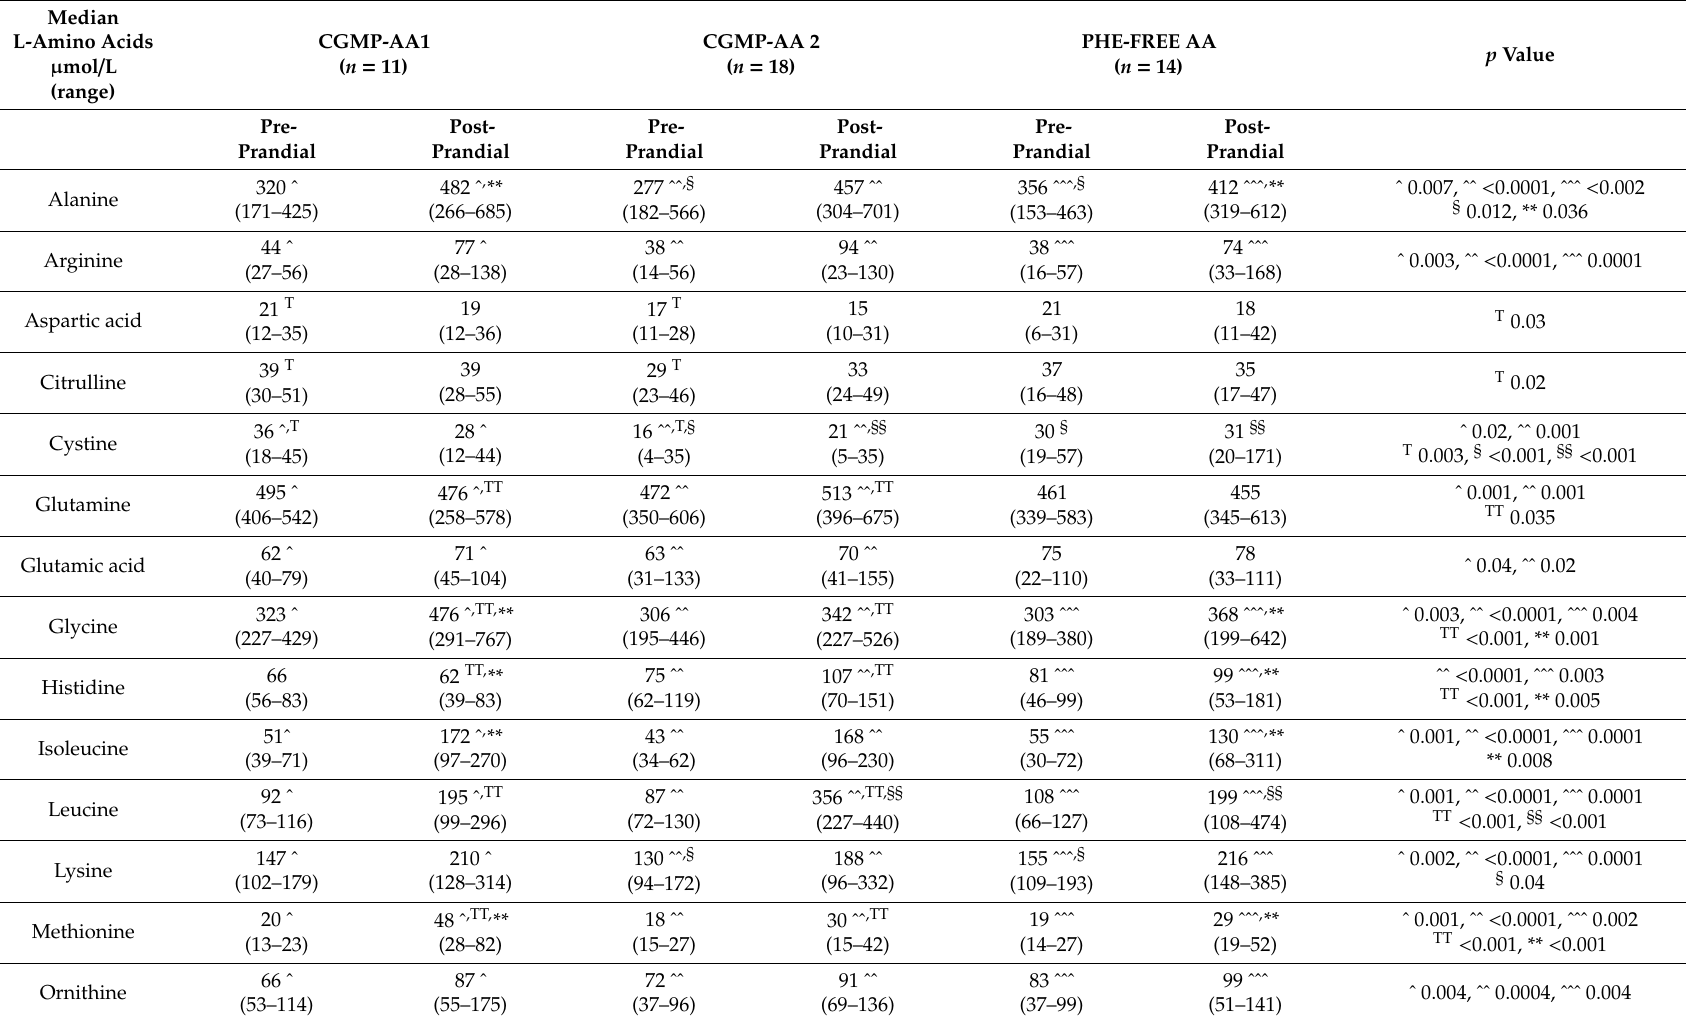
Table 2. Median (range) fasting pre and postprandial individual amino acids for CGPM-AA1, CGMP-AA2, and PHE-FREE AA protein substitutes. Median L-Amino